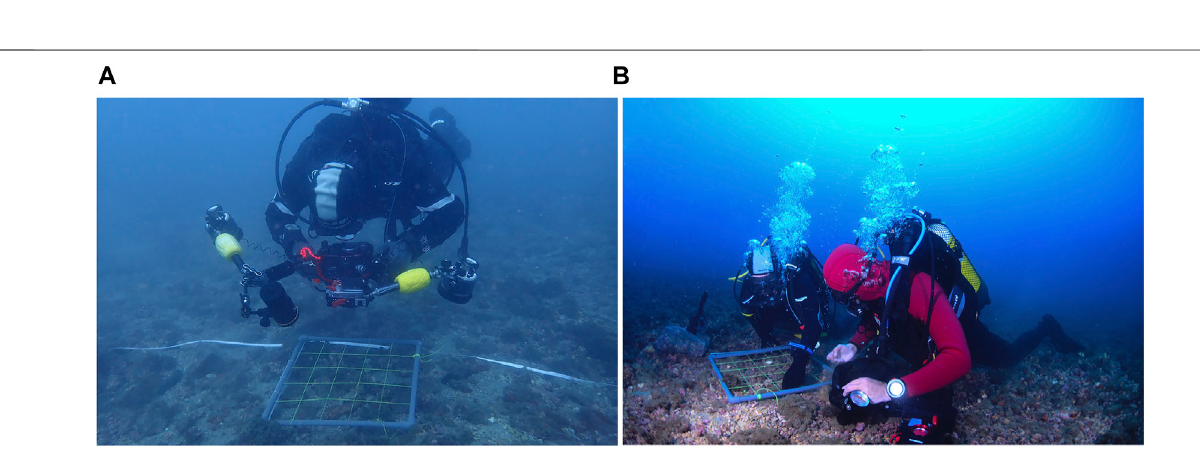
Frontiers in Earth Science |